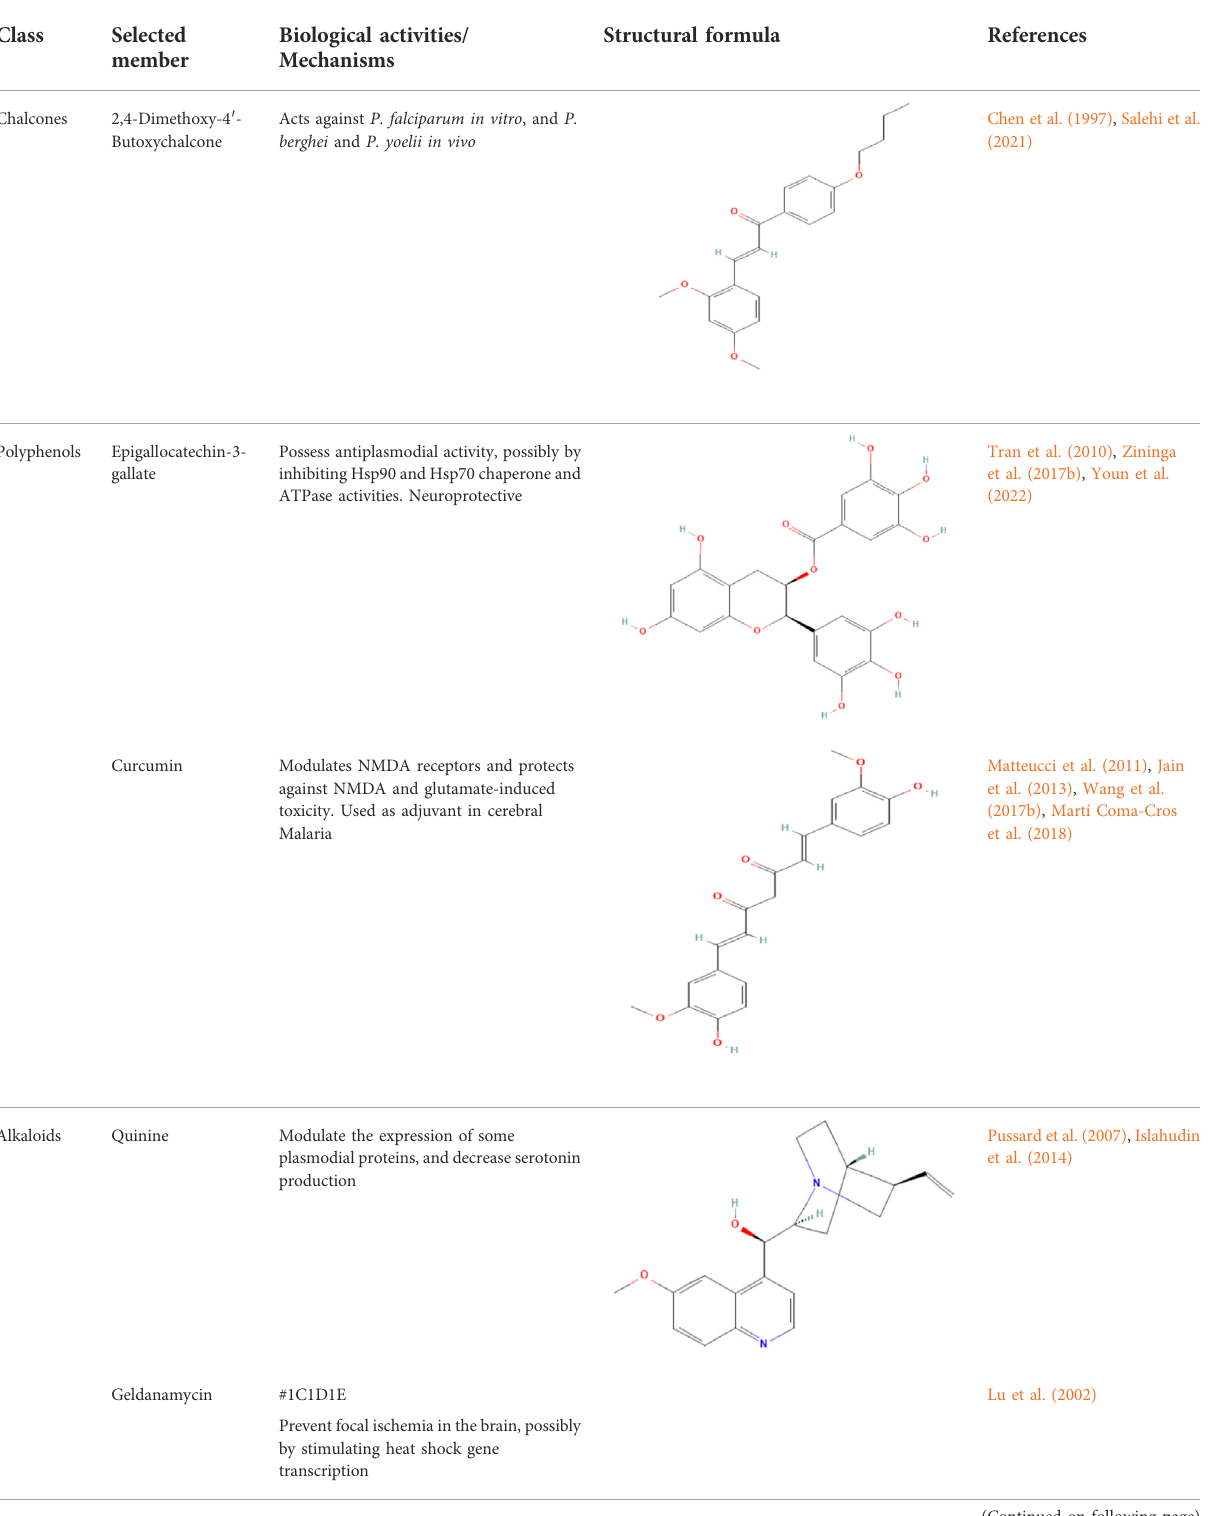
TABLE 1 Features of selected small molecule inhibitors of molecular chaperones with antimalarial/antiplasmodial